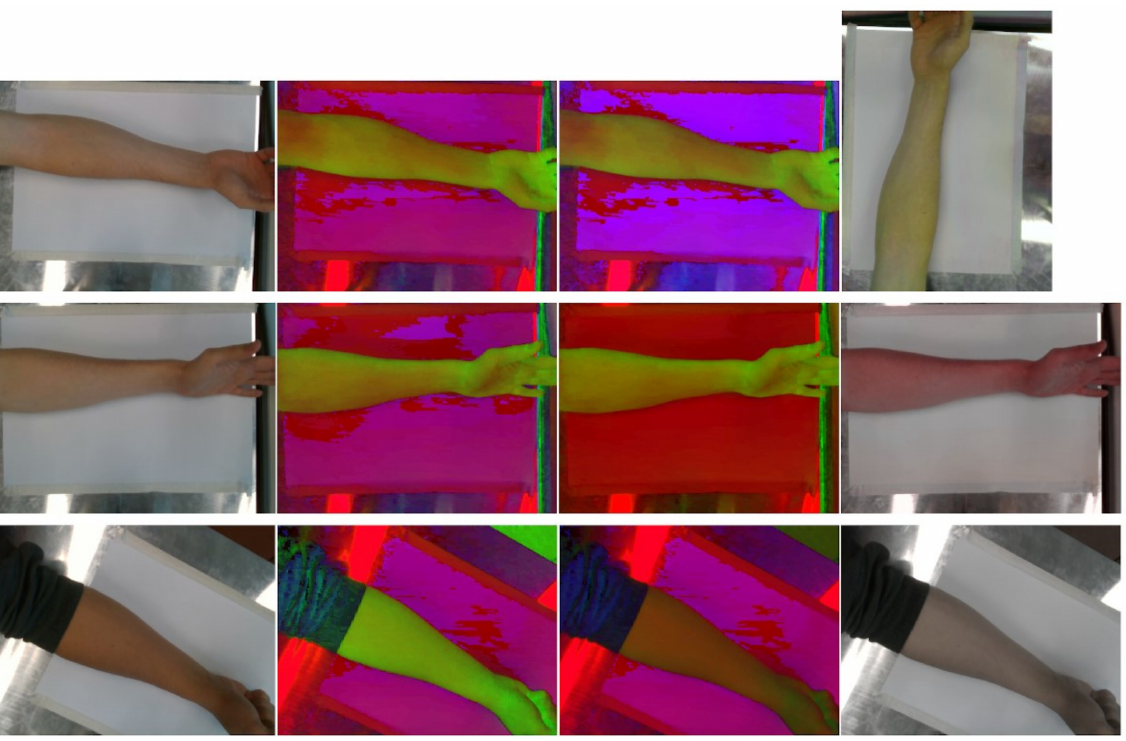
Figure 5. Image in RGB, image in HSV, augmented image in HSV, augmented image in RGB (from left to right), first row: H-V modified and rotated by 270°, second row: S-V modified, third row: H-S